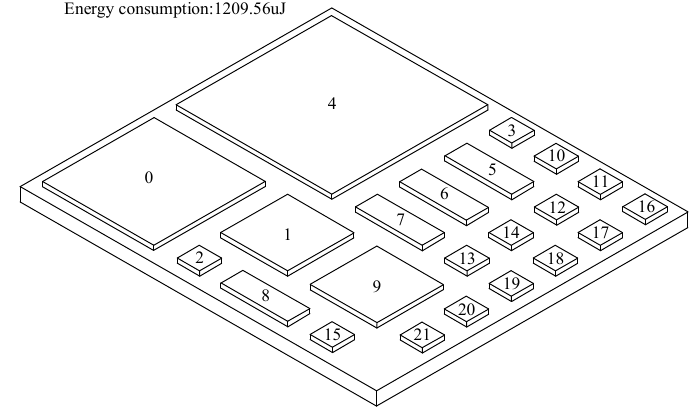
Figure 3. The representation of chiplet location and distance between chiplets. Figure 4. The initial layout of the 2.5-D IC